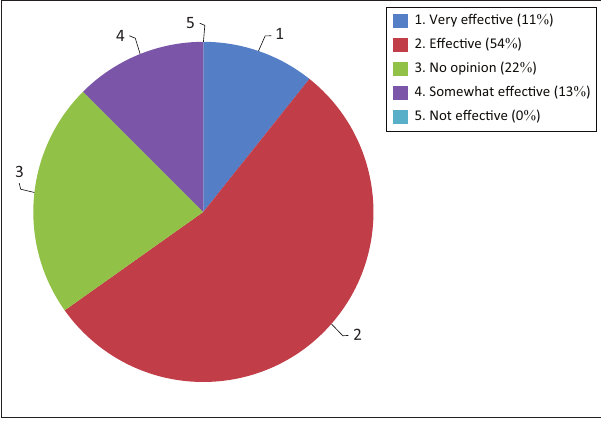
FIGURE 6: Participants’ opinions of mentoring as a knowledge transfer tool ( n =